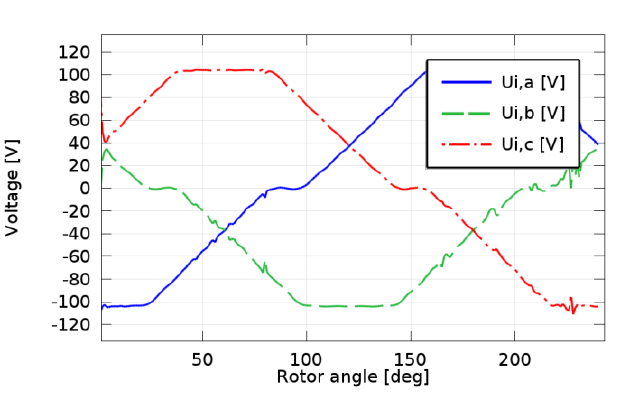
Fig. 9. The alternating phase voltage excitation applied on the locked rotor machine.